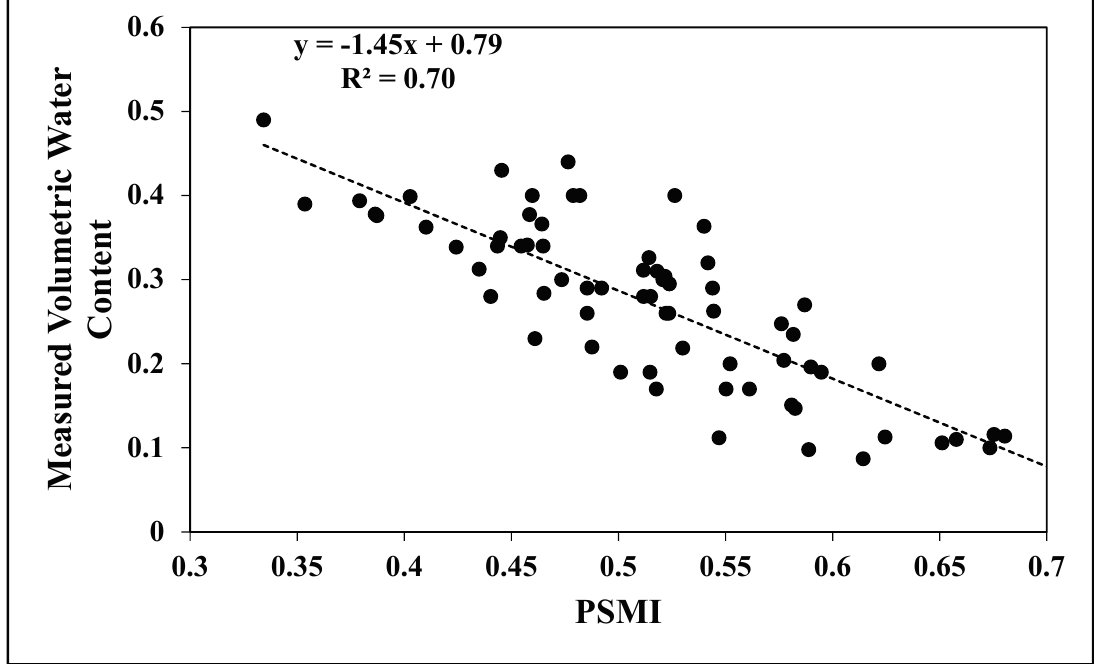
Figure 9. Simple linear regression between field measurements of volumetric soil water content and corresponding values of PSMI calculated from multispectral satellite image